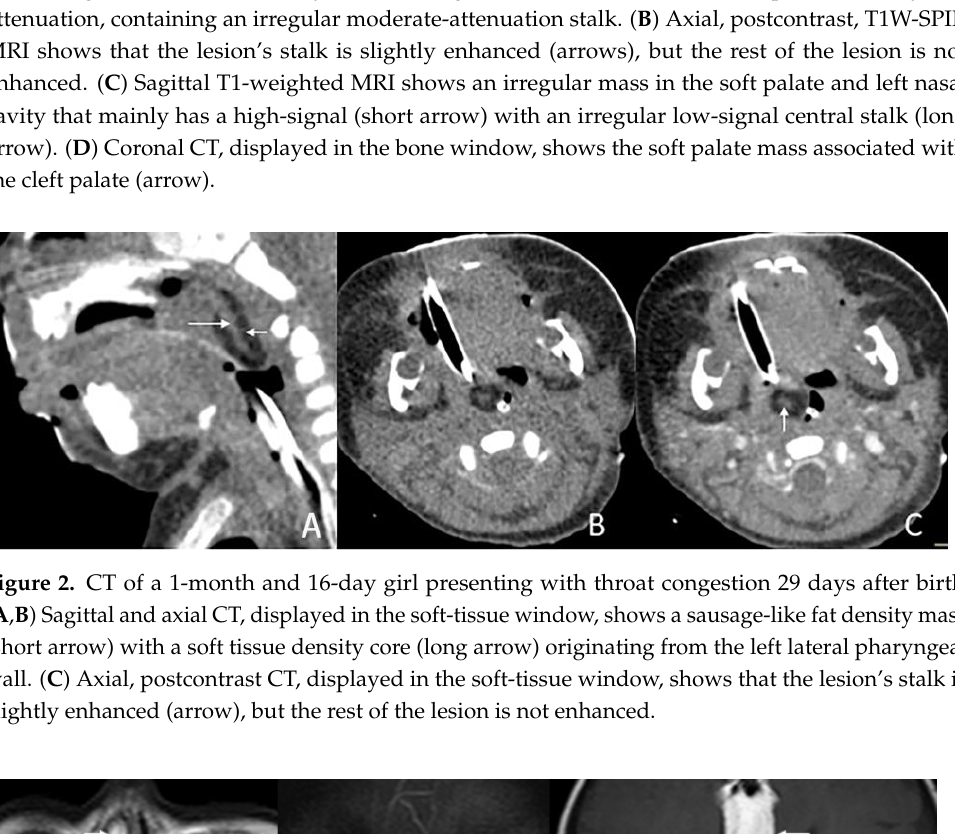
Figure 2. CT of a 1-month and 16-day girl presenting with throat congestion 29 days after birth. ( A , B ) Sagittal and axial CT, displayed in the soft-tissue window, shows a sausage-like fat density mass (short arrow) with a soft tissue density core (long arrow) originating from the left lateral phar- yngeal wall. ( C ) Axial, postcontrast CT, displayed in the soft- tissue window, shows that the lesion’s stalk is slightly enhanced (arrow), but the rest of the lesion is not enhanced.